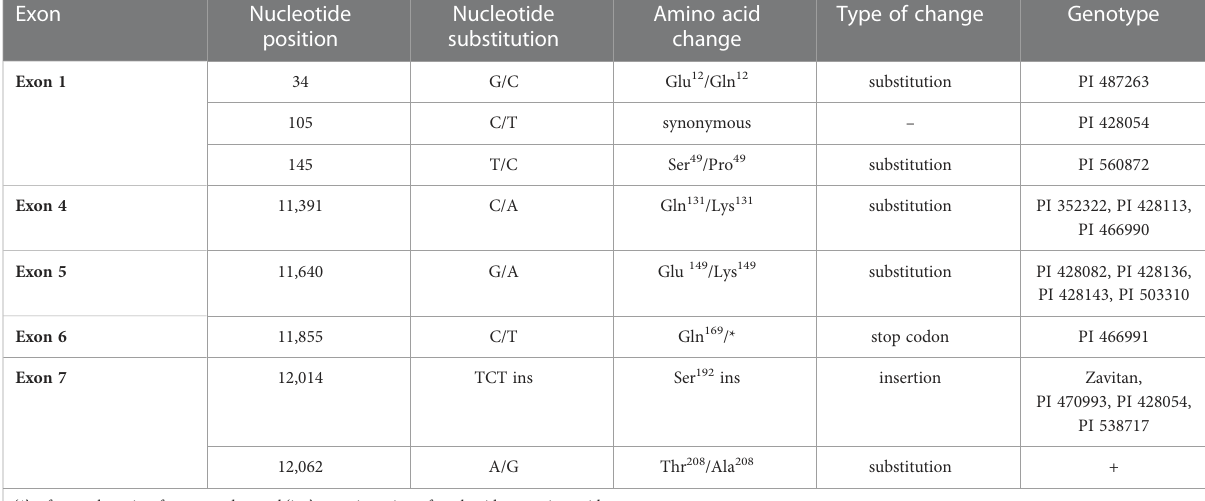
TABLE 2 Mutations within VRN-B1 exons. ´+´ group contains large number of genotypes (18) listed in the Supplementary Table 16